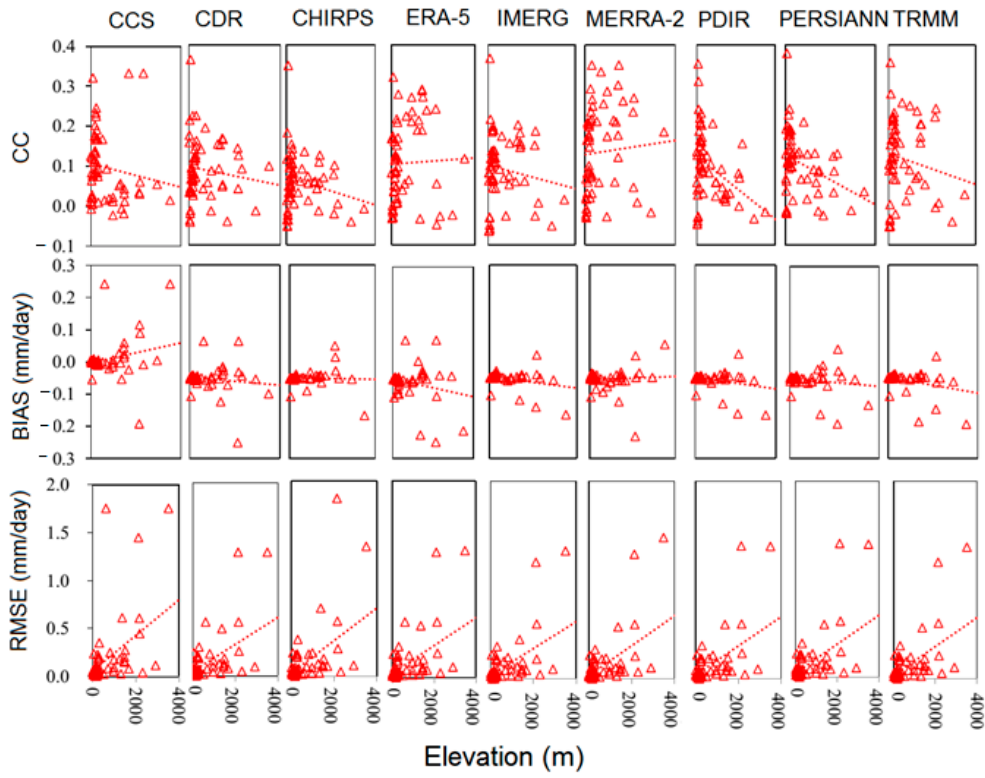
Figure 11. Influence of the precipitation intensity on daily time scale evaluation indices.